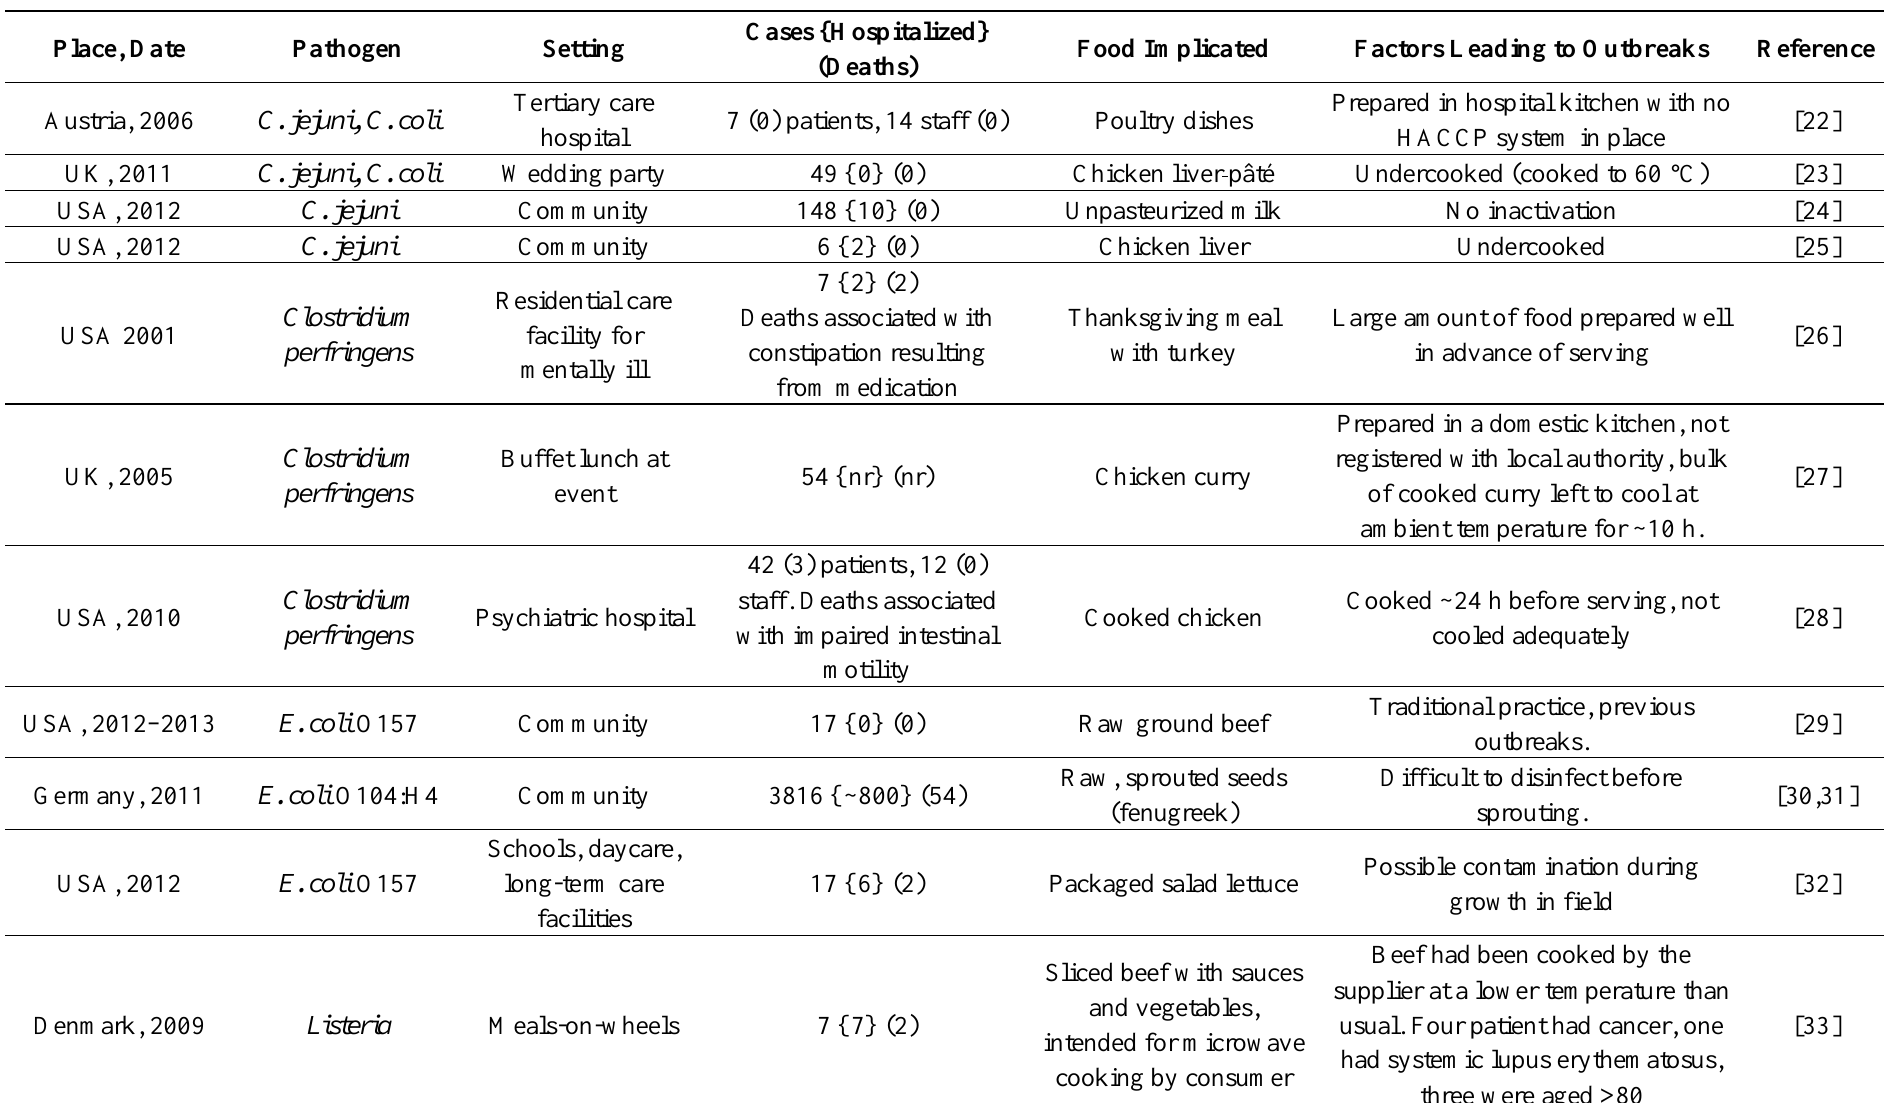
Table 8. Examples of foodborne outbreaks and contributing